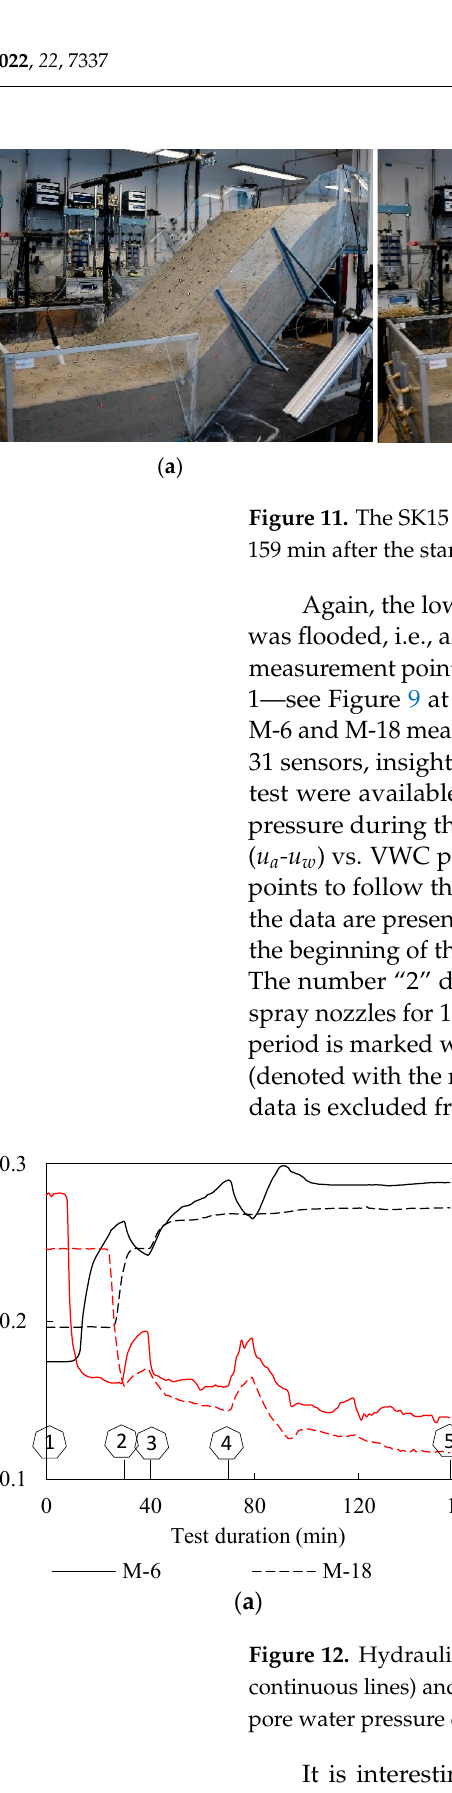
Figure 12. Hydraulic monitoring data from the test considered in Example 2 for points at 6 (M-6, continuous lines) and 18 cm depth (M-18, dashed lines) on the M measurement profile: ( a ) VWC and pore water pressure changes during the test; and ( b ) data in the logarithmic ( u a -u w ) vs. VWC plane.